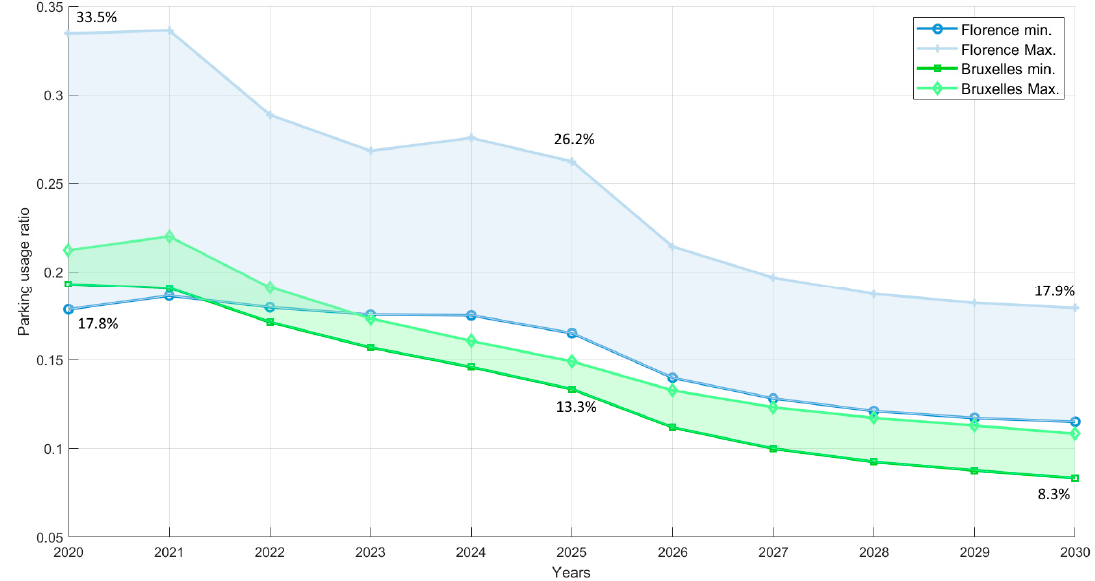
Figure 13. Public stall usage ratio by publicly accessible charging infrastructure for Florence (light blue) and Bruxelles (light green).